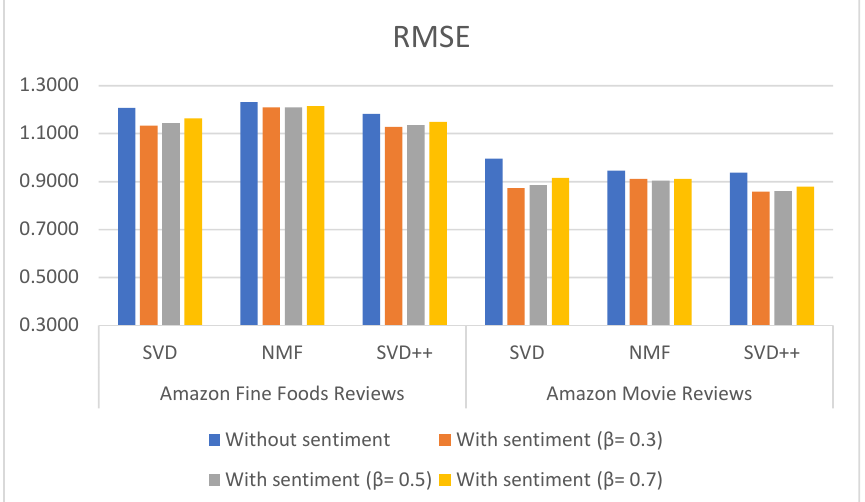
Figure 7. RMSE measures the comparison for different types of methods and datasets using L-CNN sentiment model. Table 5. NMAE values without and with L-CNN sentiment analysis model.